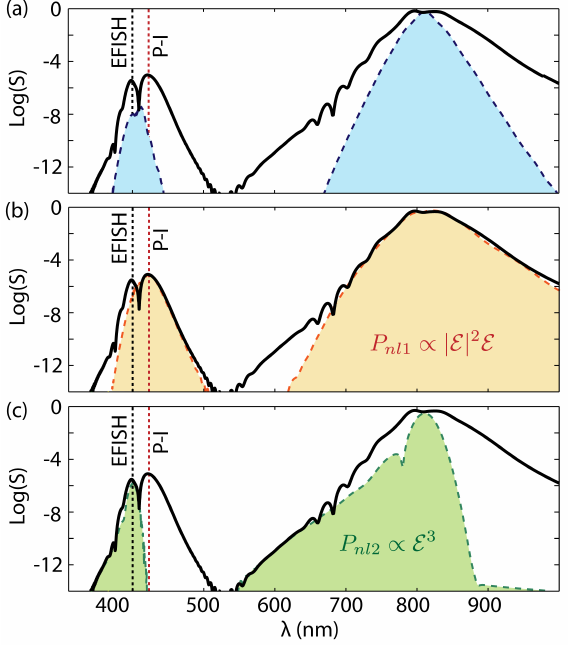
Figure 3. ( a ) Numerically simulated spectra for the total (pump and THz) field—spectra are shown at the sample output ( z = 5 mm). The light blue shaded area is for low pump intensity, while the thick black curve is for high pump intensities (S stands for power spectrum). ( b ) Same as in (a), but comparing—for the high energy case—the results from a full simulation (black solid curve) with those (cid:2) |E| 2 E (cid:3) from a simulation accounting only for the P nl 1 ∝ Re (red shaded curve). ( c ) Same as (b), but (cid:2) E 3 (cid:3) comparing the full simulation (black solid curve) with one including only the P nl 2 ∝ Re term (green shaded curve). PI: phase insensitive